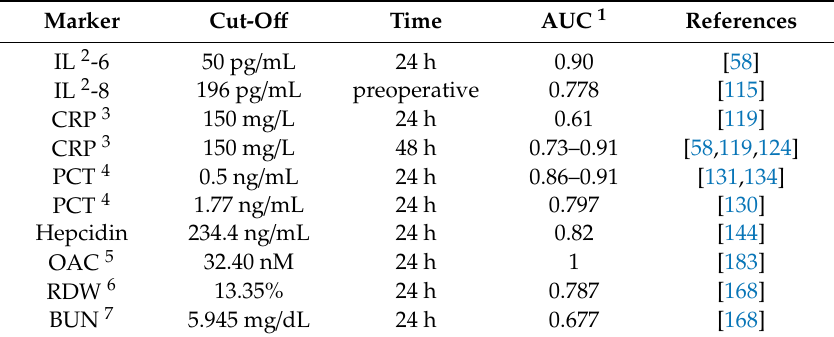
Table 2. Clinically relevant biochemical markers predicting disease severity in AP.